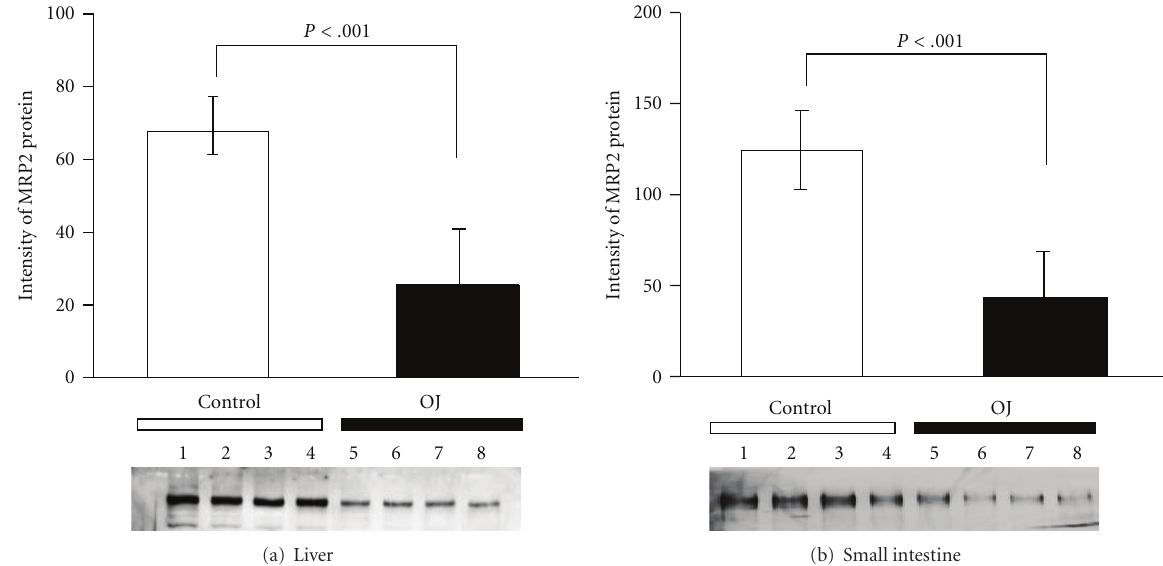
Figure 2: E ff ect of orange juice (OJ) on Mrp2 protein levels in both the liver (a) and small intestine (b) in rats. OJ or tap water was given according to the same schedule as in Figure 1. The liver and small intestine were removed 1h after the last ingestion of OJ or tap water, respectively, and plasma membrane fractions were prepared. Details of the Western blot analysis are described in Section 2.